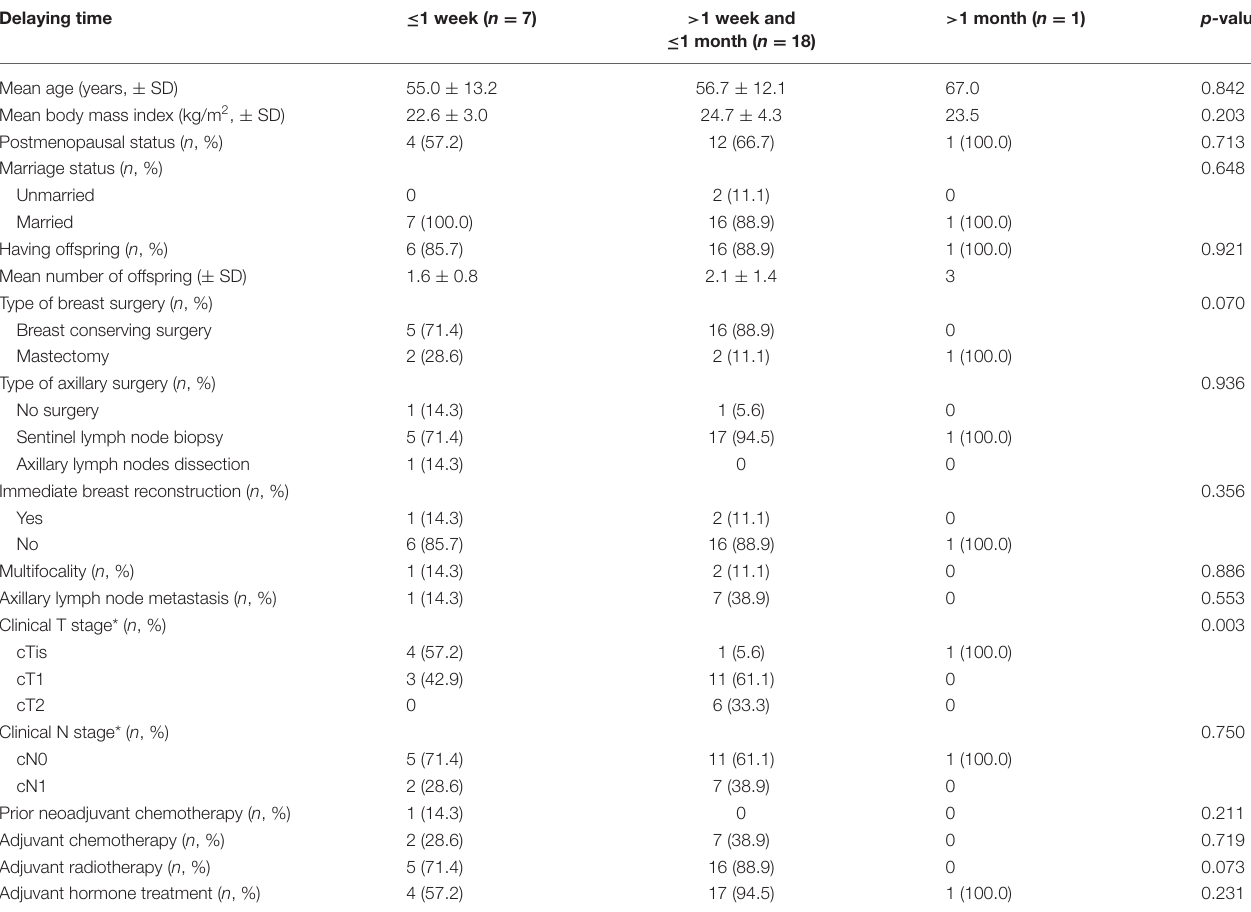
TABLE 3 | Clinicopathological characteristics of patients with breast cancer who delayed surgery during the COVID-19 outbreak. Delaying